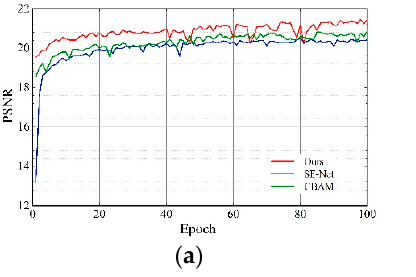
( b ) Figure 6. Effects of ablation study (1).